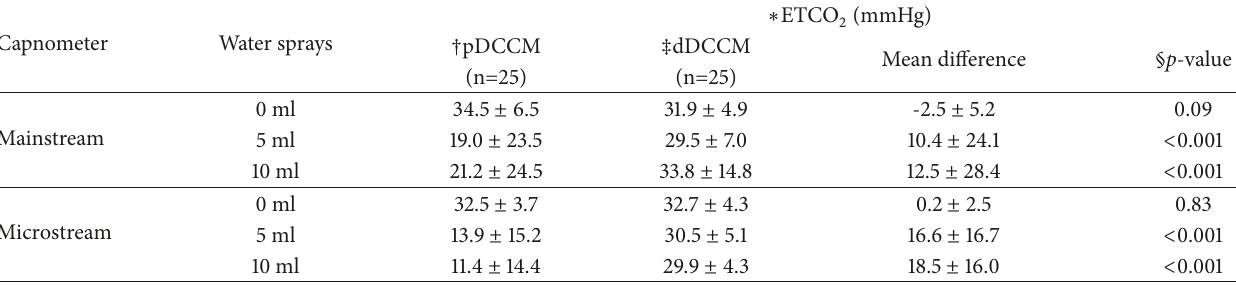
Table 2: ETCO 2 by using pDCCM and dDCCM.